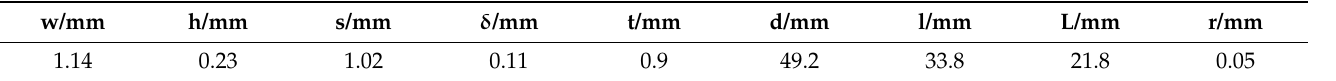
Figure 2. Schematic diagram of different groove depths of pipe sleeve model. Table 1. Table of dimensional parameters of the tube-tube sleeve model.